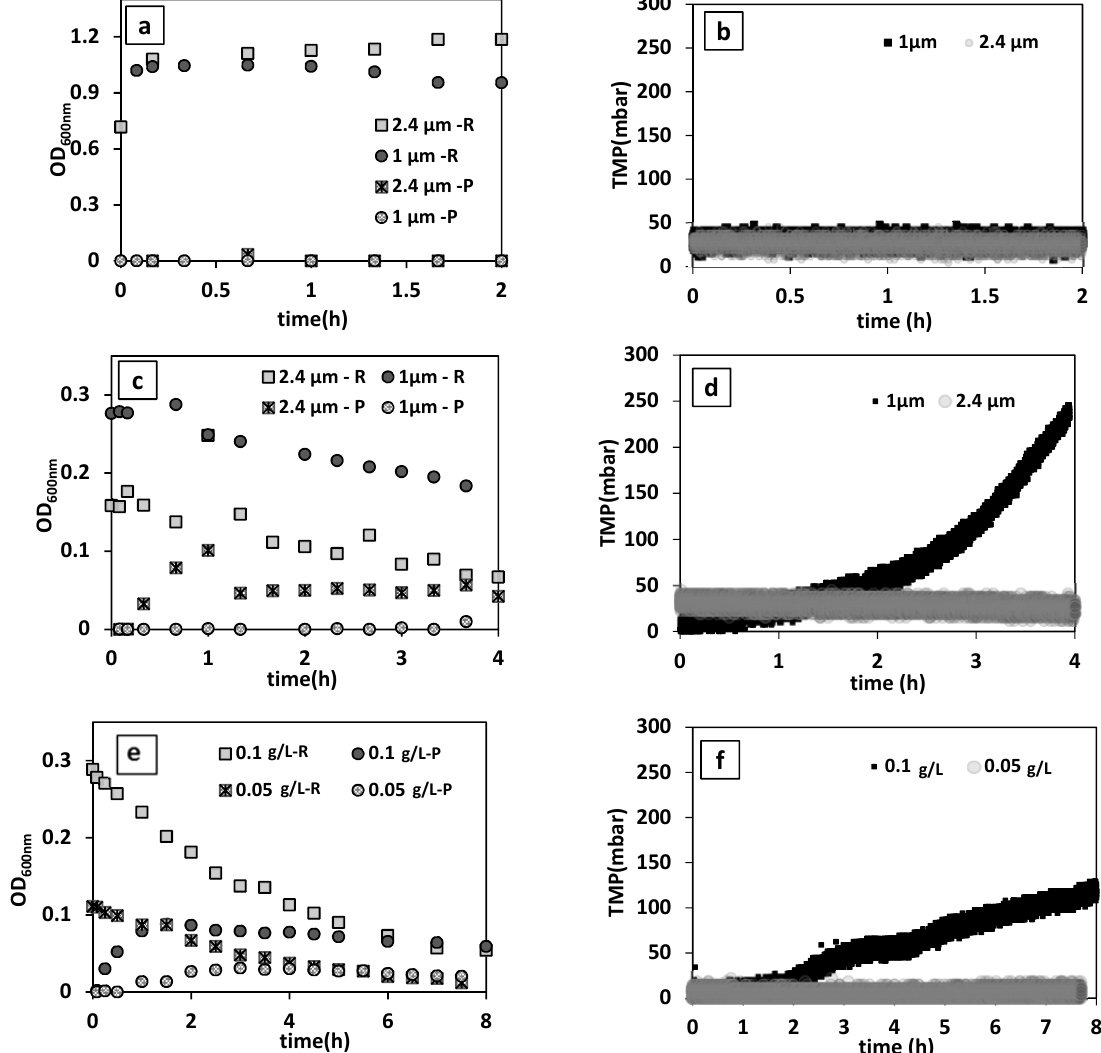
Figure 3. The effect of membrane pore size (1 µ m and 2.4 µ m) on the changes in the turbidity of reactor medium (R) and permeate (P), and corresponding changes in TMP during filtration of yeast ( a , b ) and bacteria ( c , d ) suspension. The effect of initial bacteria inoculum size (0.05 g/L and 0.1 g/L) on the ( e ) optical density of the medium and ( f ) TMP during filtration.